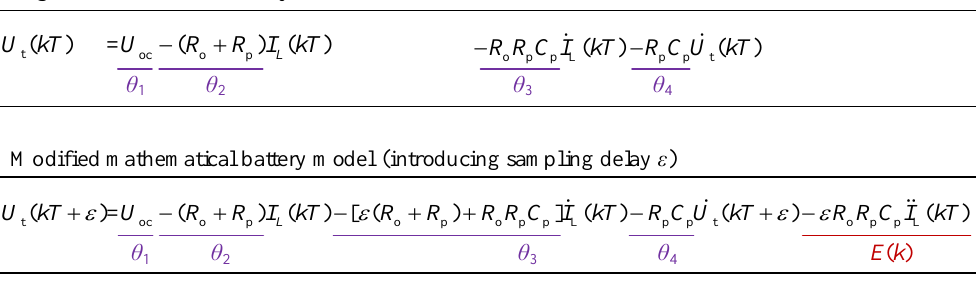
Figure 2. The influence of sampling delay on the mathematical battery model.